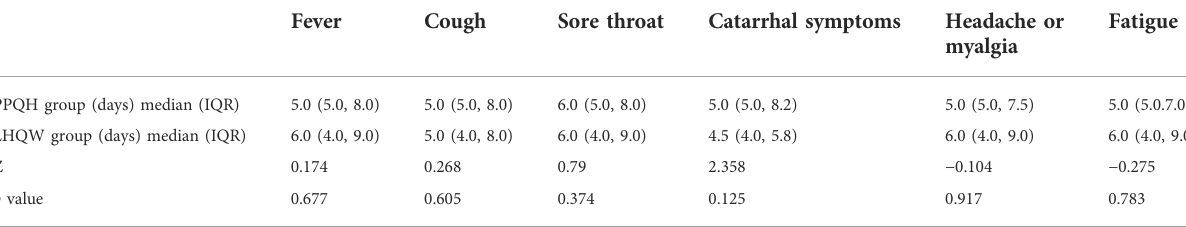
TABLE 5 Comparison of the recovery time of symptoms between the two groups of SARS-CoV-2-infected patients. Cough